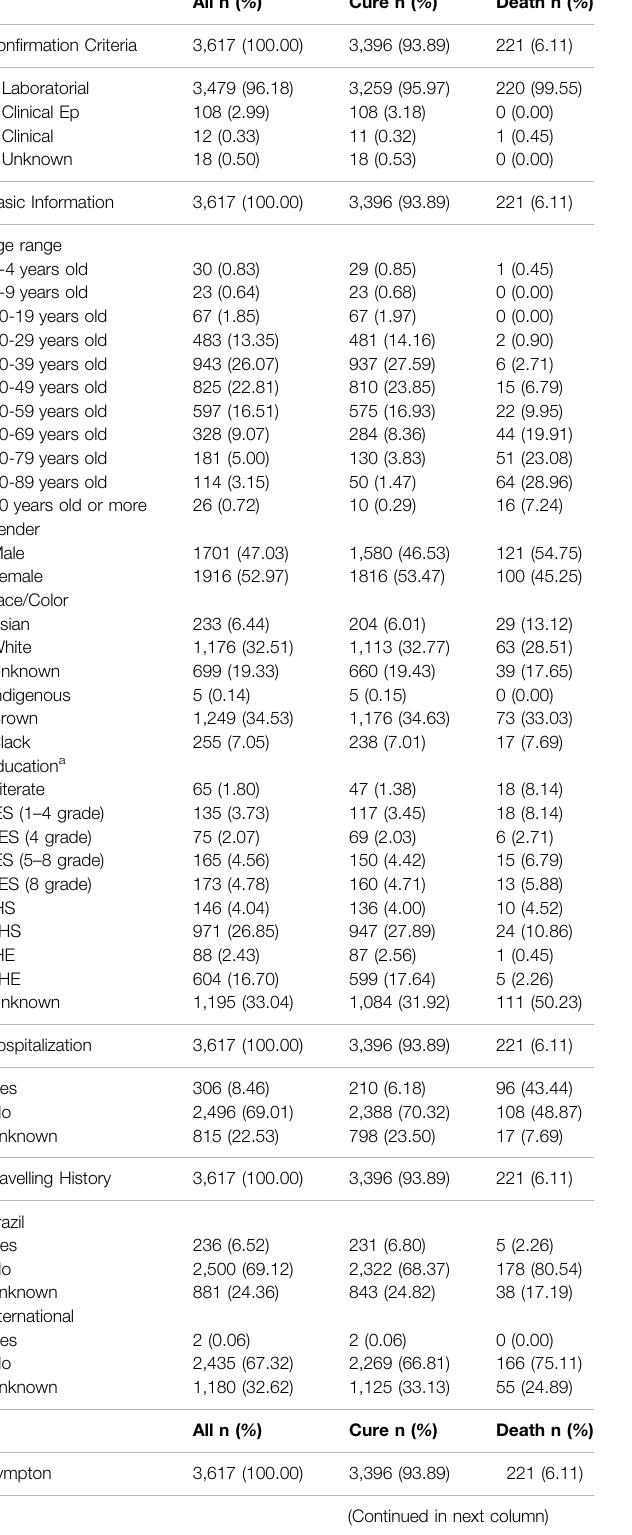
TABLE 2 | Demographic data and clinical characteristics of the study populationValidation Dataset (May 24th - May 30th).